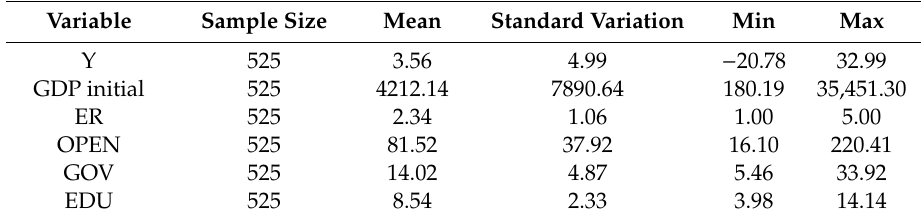
Table 3. Descriptive statistics of